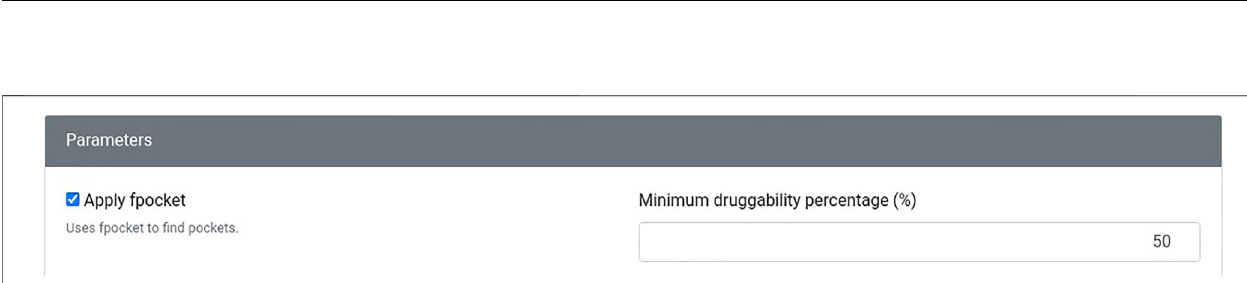
Frontiers in Pharmacology |